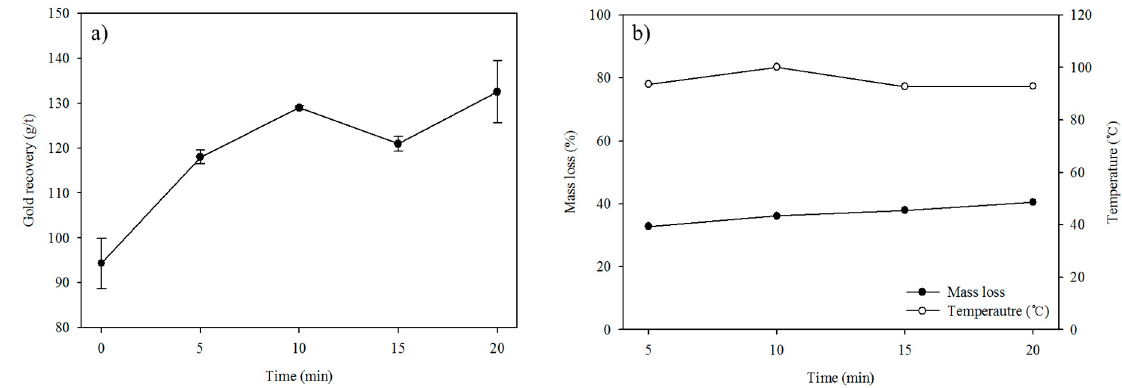
Figure 14. Effect of leaching time on ( a ) recovery of gold and ( b ) mass loss and reaction temperature from the refractory gold concentrate. The leaching conditions were an HNO 3 concentration of 2.0 M.